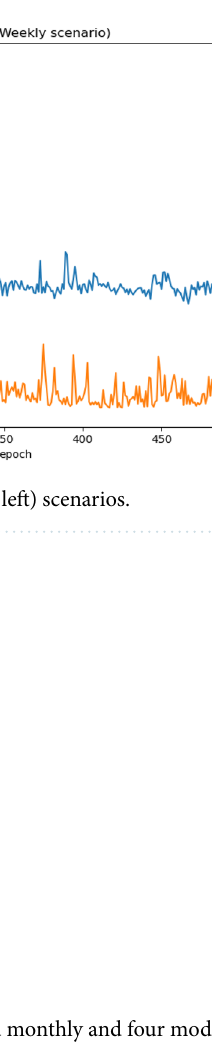
Table 3. Sensitivity analysis of inputs for four scenarios: daily, weekly, 10-days, and monthly and four models: Elastic Net, MLP, XGB, and